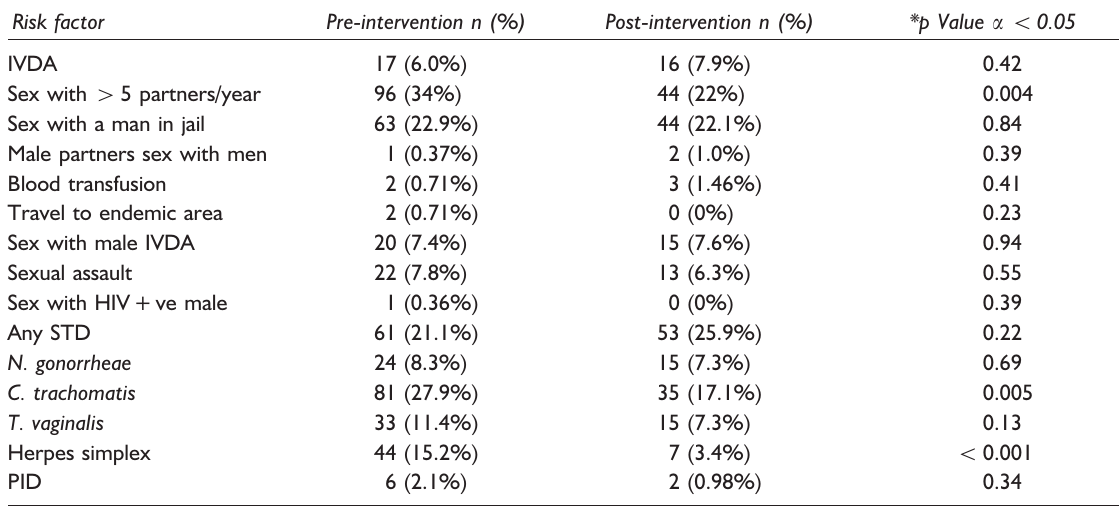
Table 3 Historical risk factors for HIV acquisition by group Risk factor